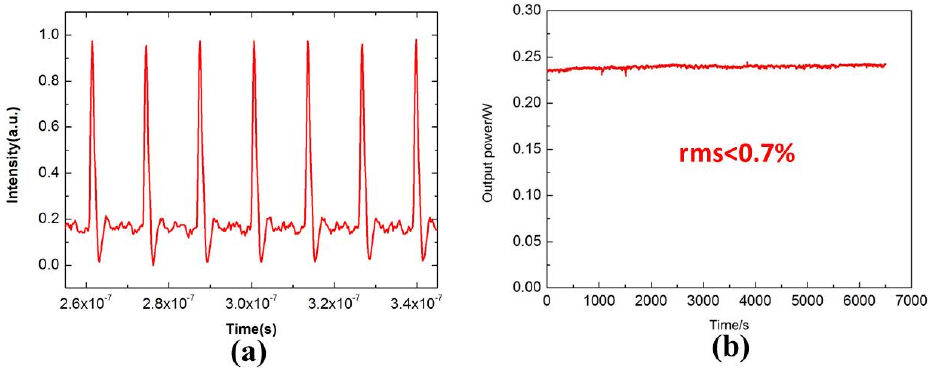
Figure 1. Set-up diagram and photograph of the picosecond oscillator. M1, M2: plane-concave pump mirrors, R = 75 mm; M3, M4, M6: high-reflection plane mirrors; M5: concave mirror, R = 200 mm; M7: output coupler, T = 10%.